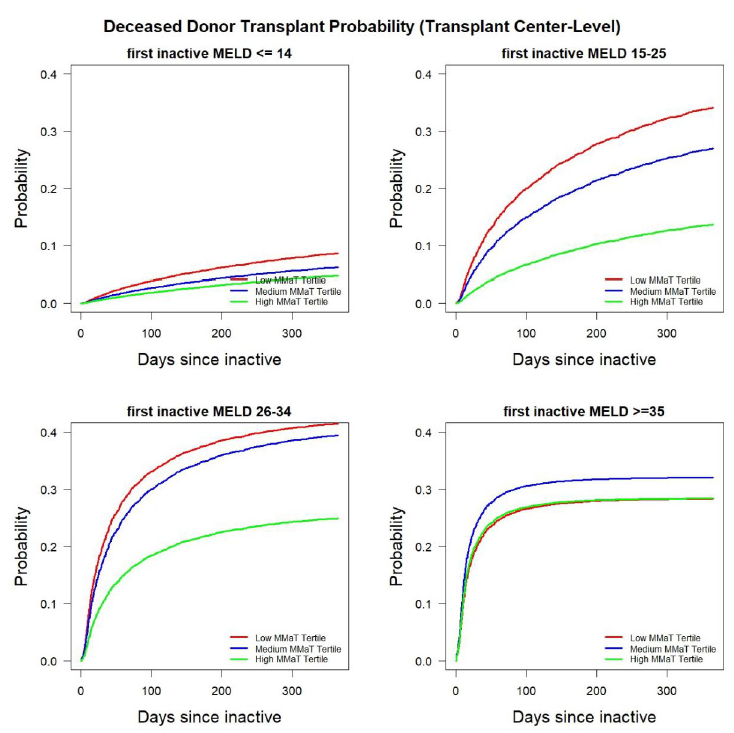
Fig 3. Probability of receiving deceased donor transplant among inactive waitlist candidates stratified by candidate MELD group and MMaT at the transplant center-level.